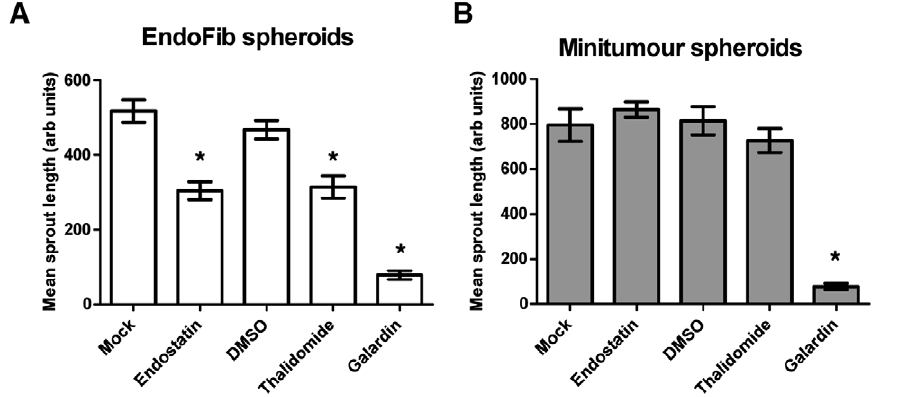
Figure 5. Minitumour spheroids have a different drug response than spheroids consisiting of only HUVEC and fibroblasts. A – Incubation of EndoFib spheroids with different anti-angiogenic agents for 40 h shows inhibition of sprouting with Thalidomide, Endostatin and Galardin. B – Incubation of Minitumour spheroids with different anti-angiogenic agents for 40 h shows a response to Galardin but a non-significant effect of both Thalidomide and Endostatin.